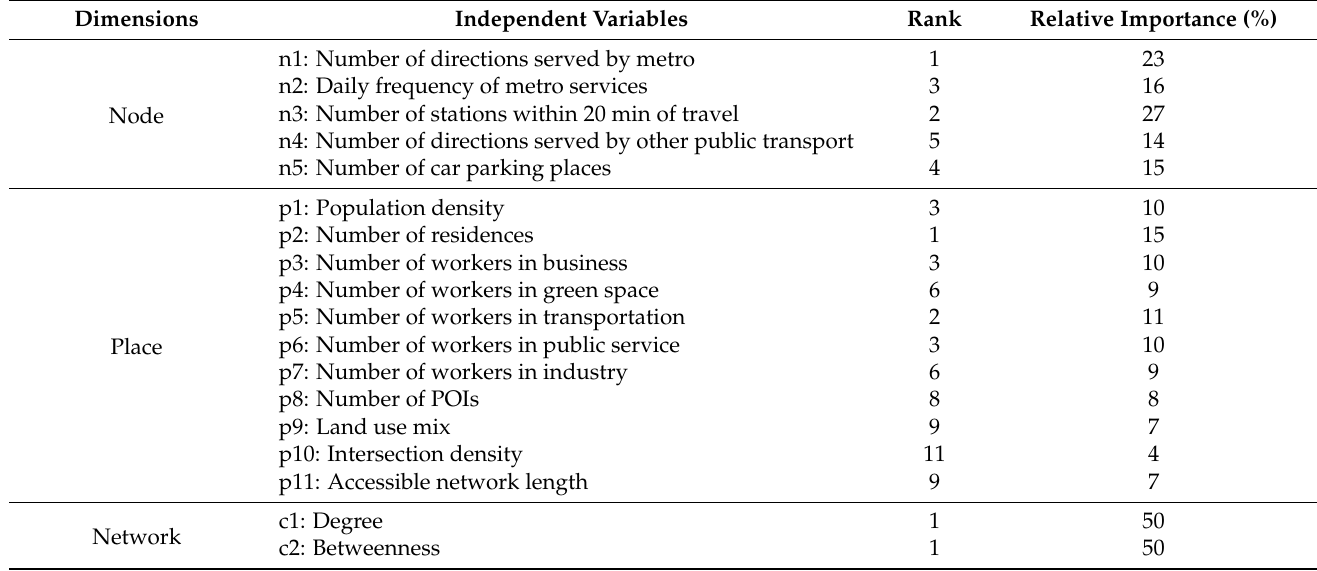
Table 3. Indicators of the node dimension.